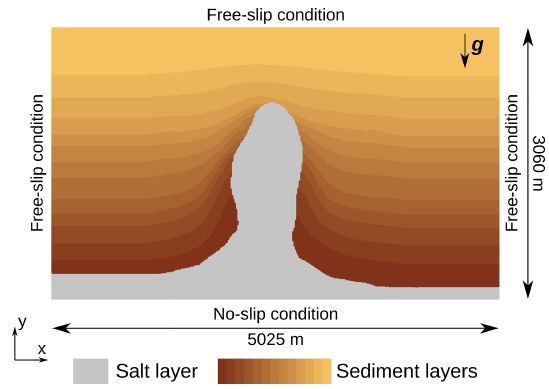
Figure 7. Error logarithmic distribution for the second experiment (variable viscosity) on the diapiric growth model. Figure 8. Setup of the simulation for the model generated with the method proposed by Clausolles et al. (2019). The initial model is sampled on a regularly spaced particle swarm.